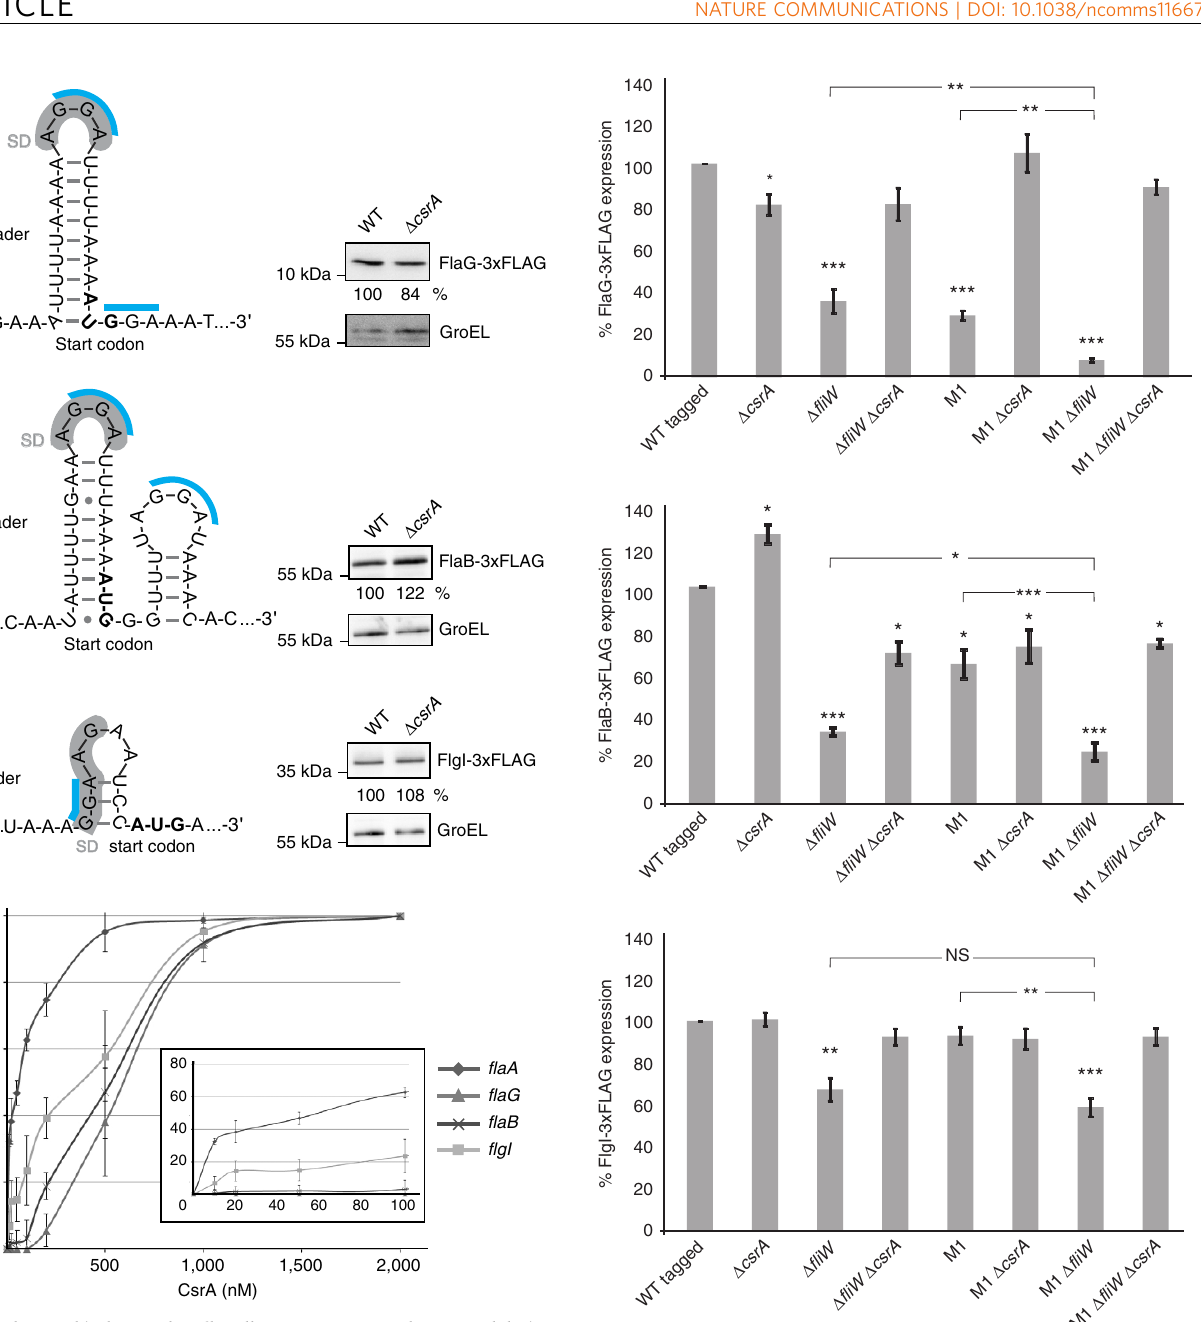
titrate CsrA activity. To investigate the role of FliW and the flaA mRNA as CsrA antagonists, we analysed FlaG-3xFLAG, FlaB- 3xFLAG and FlgI-3xFLAG protein expression in loss-of-function strains of both antagonists. In line with FliW acting as a general CsrA antagonist that limits CsrA activity, deletion of fliW led to a B 3-fold decrease in FlaG-3xFLAG level, which was restored to WT level in a D csrA / D fliW double mutant (Fig. 5 and Supplementary Fig. 13a).